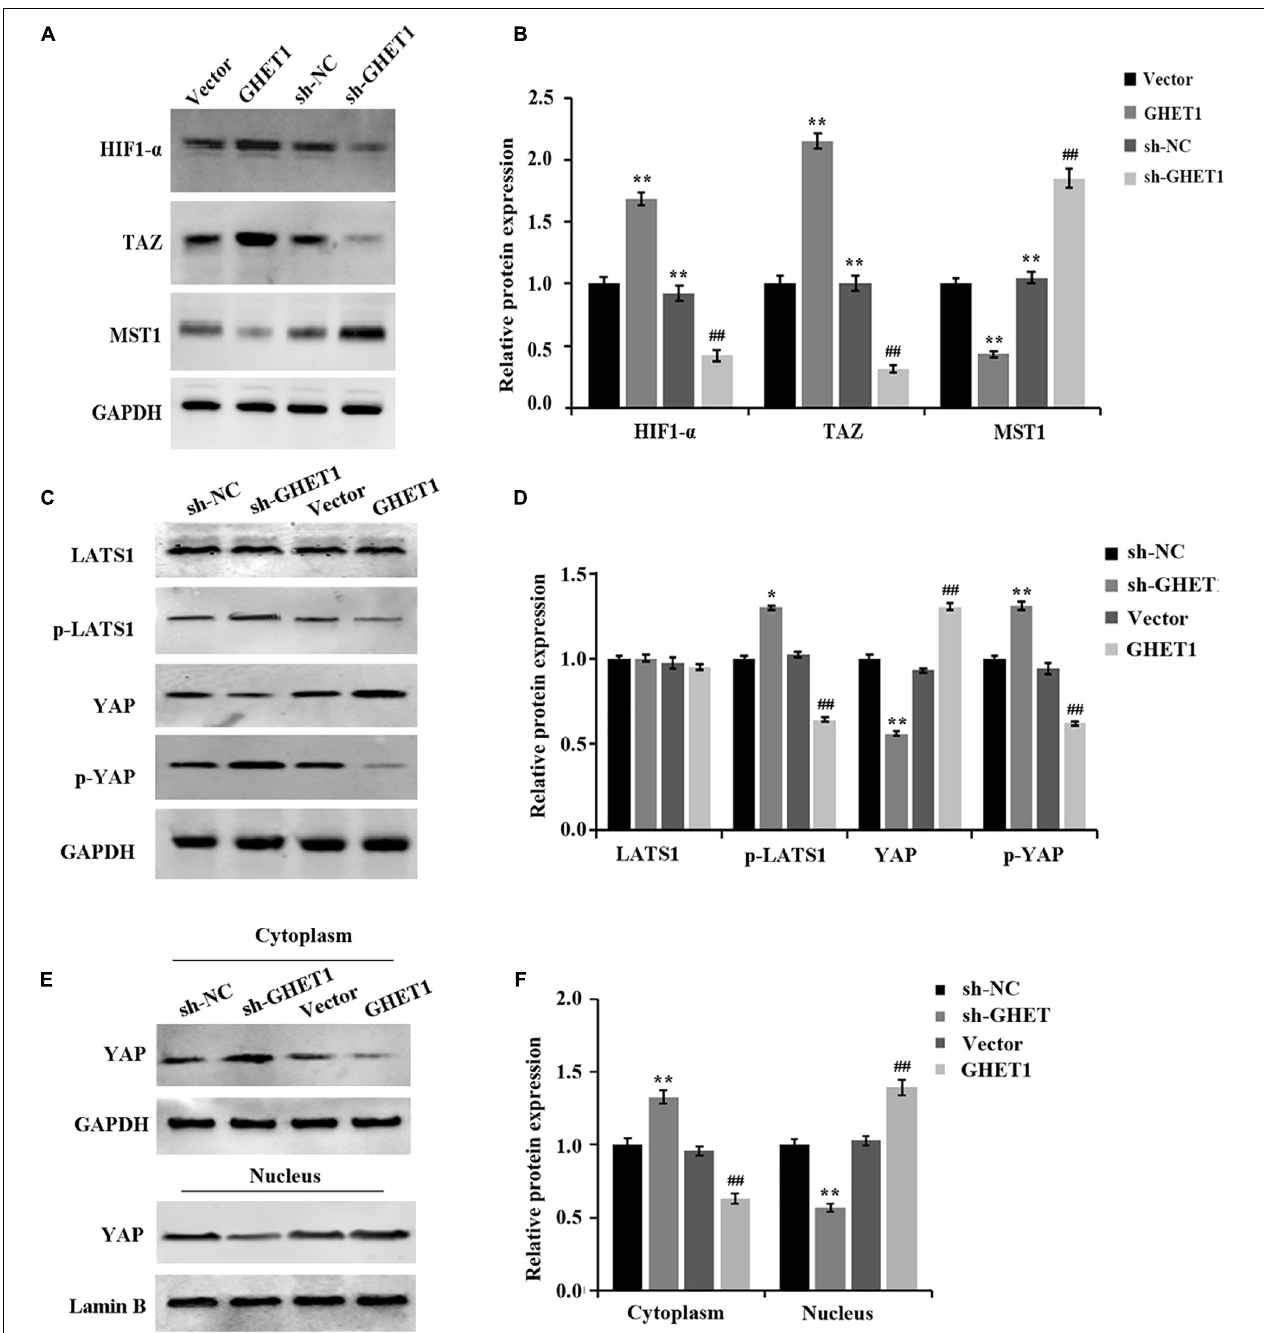
FIGURE 6 | Promotion of in vivo Hippo/YAP pathway activation and YAP nuclear translocation in triple-negative breast cancer by lncRNA GHET1. (A–D) Proteins expression of HIF- α and the indicated Hippo/Yap pathway in xenograft tumor tissues was detected by western blot. (E,F) Expression of YAP in the cytoplasm and the nucleus of the xenograft tumor tissues was analyzed using western blot. * p < 0.05 and ** p < 0.01 vs. sh-NC group; # p < 0.05 and ## p < 0.01 vs. Vector